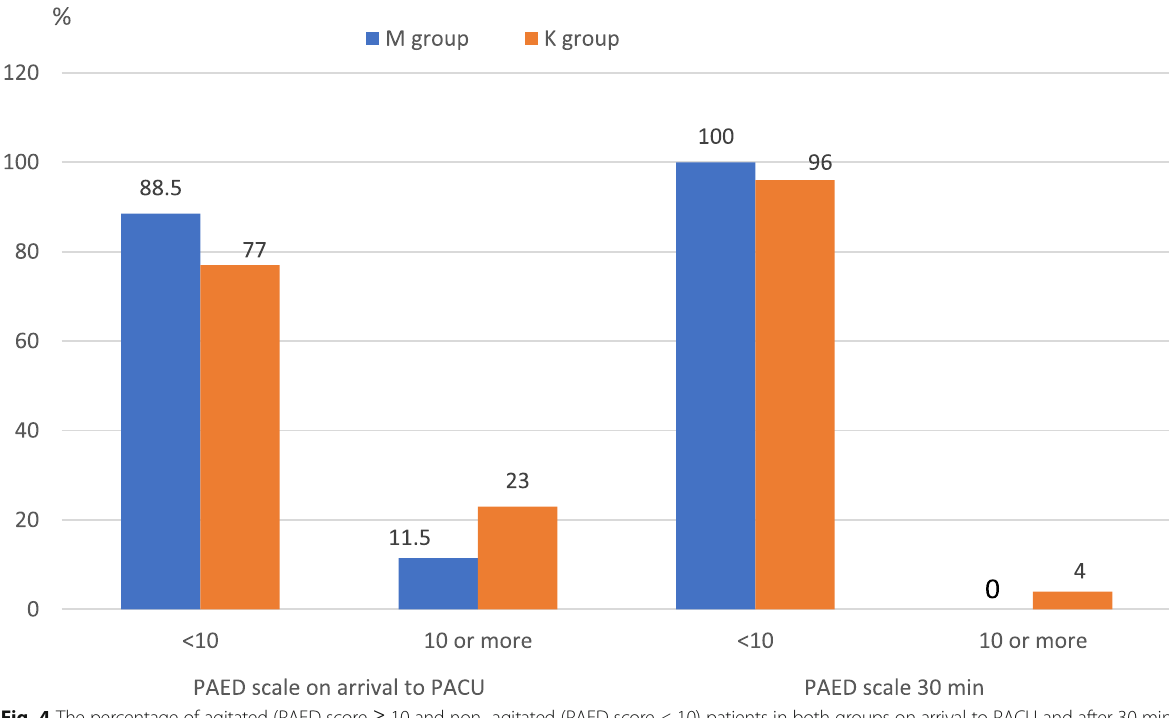
Fig. 4 The percentage of agitated (PAED score ≥ 10 and non- agitated (PAED score < 10) patients in both groups on arrival to PACU and after 30